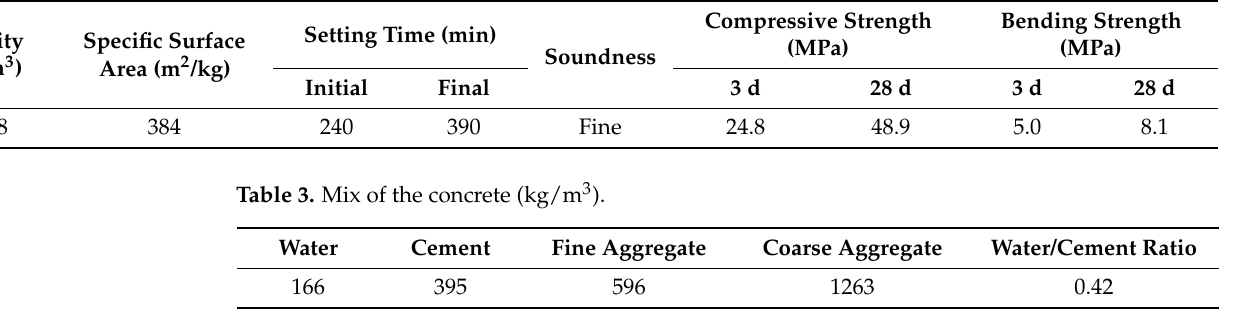
Table 2. Performance index of cement P. O. 42.5 R.